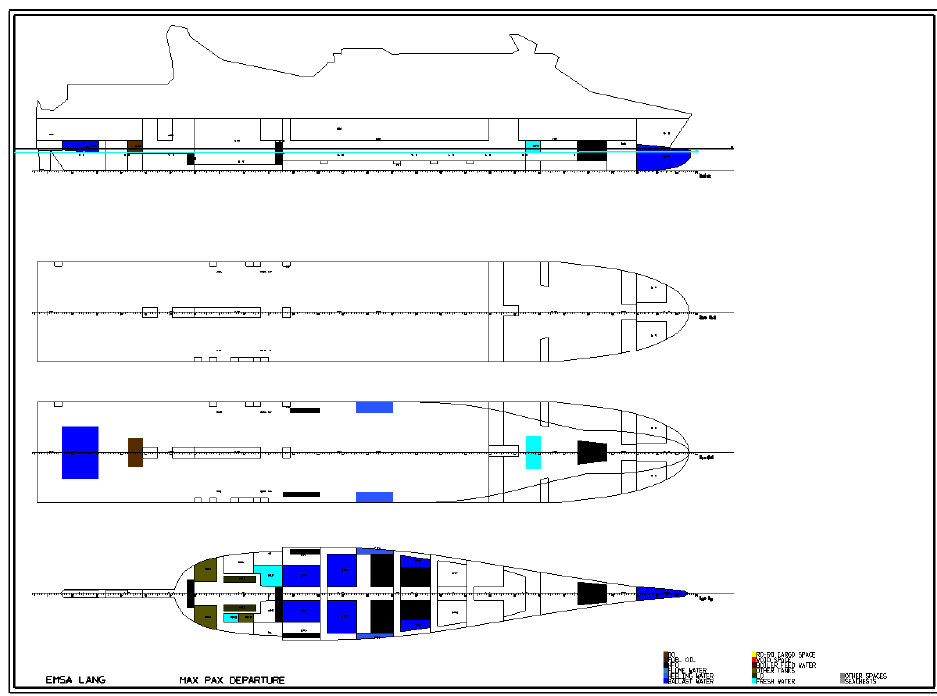
Figure 9. Loading condition Pax Departure for the EMSA-RoPax.